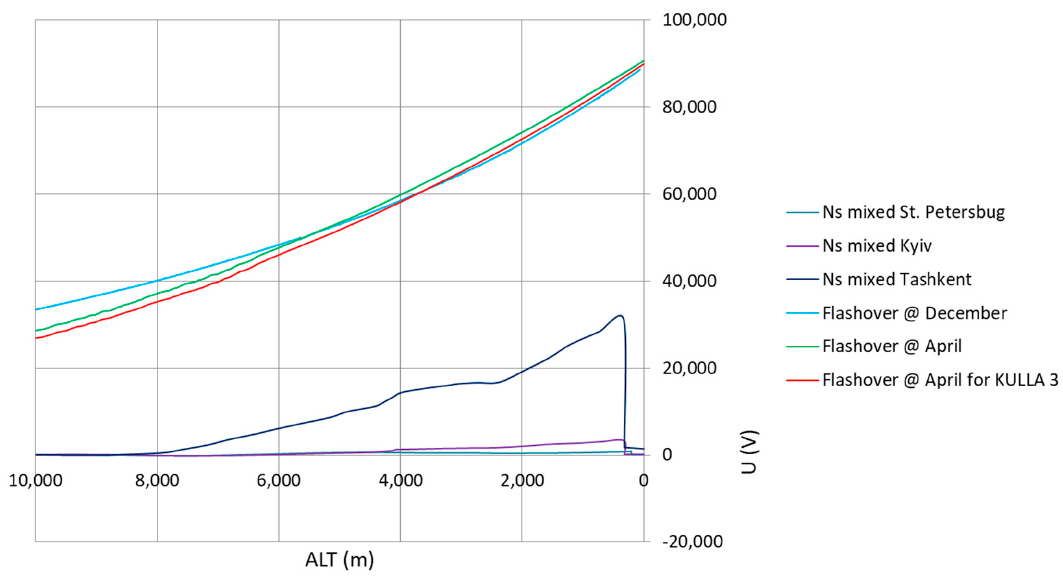
Figure 7. The flashover and induced voltage for the re-entry through the Nimbostratus clouds on the 140 m-long fully airborne antenna.